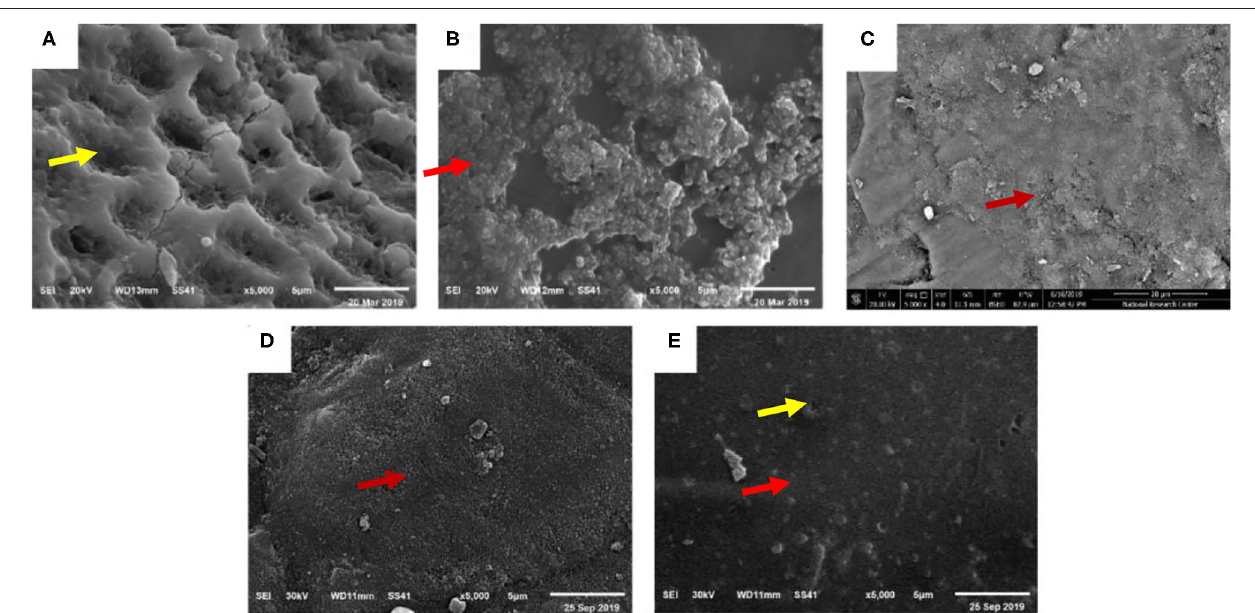
FIGURE 11 | Scanning electron microscopy (SEM) image × 5,000 showing, (A) outer surface of untreated enamel caries like lesions showing obvious dissolution of the prisms or interprisms creating micro surface irregularities showed by yellow arrow (group I), (B) Desensibilize nano p (group II) showed smooth enamel surface showed by red arrow, (C) NHA-LPS suspension showing very smooth enamel surface and synthetic enamel surface showed by red arrow (group III), (D) NHA-SPS suspension showing few remnants of NHA showed by red arrow (group IV), and (E) NaF varnish showing some closed pores showed by red arrow and others still opened showed by yellow arrow (group